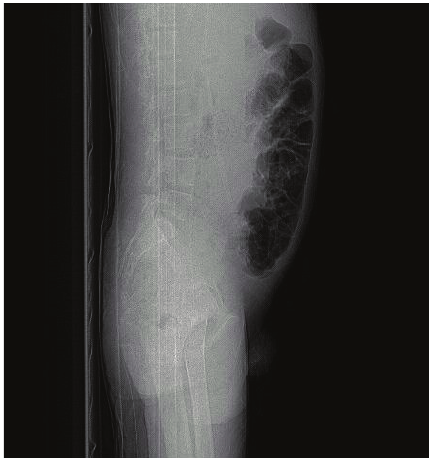
Figure 2: Lateral abdominal XR showing abdominal